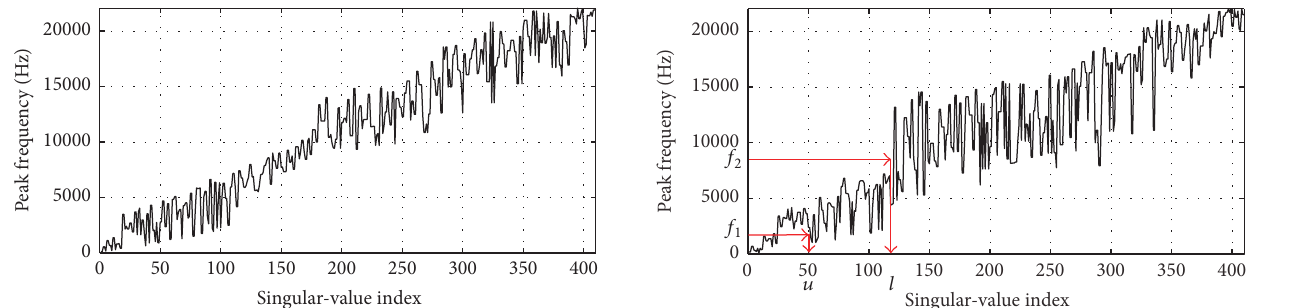
Figure 7: Relationship between frequency and singular-value index (frame size, 𝑁 = 1024 ).